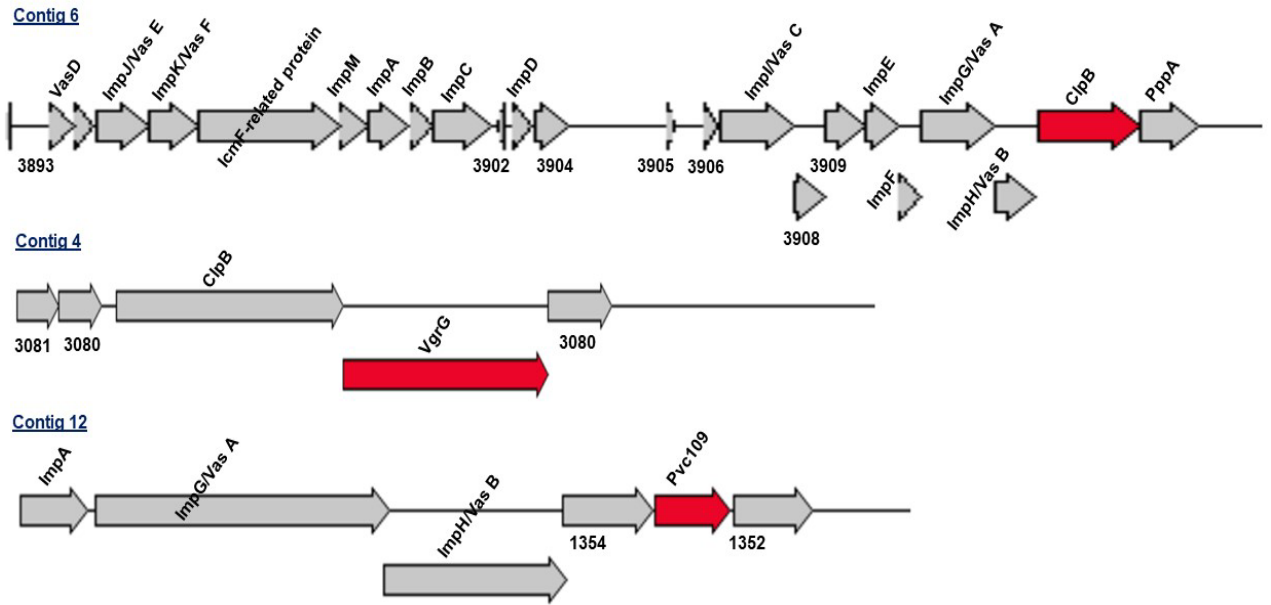
Figure 8. Genetic organization of 18 annotated T6SS gene clusters in P. stewartii subsp. stewartii Contig 6 ( VasD , ImpJ/Vas E , ImpK/Vas F , IcmF-related protein , ImpM , ImpA , ImpB , ImpC , ImpD , ImpI/Vas SQT1; Contig 6 ( VasD, ImpJ/Vas E, ImpK/Vas F, IcmF-related protein, ImpM, ImpA, ImpB, ImpC, ImpD, ImpI/Vas C, ImpE, ImpF, ImpG/Vas A, ImpH/Vas B, ClpB ); contig 4 ( ClpB, VgrG ); contig 12 ( ImpA, C , ImpE , ImpF , ImpG/Vas A , ImpH/Vas B , ClpB ); contig 4 ( ClpB , VgrG ); contig 12 ( ImpA , ImpG/Vas A ImpG/Vas A, ImpH/Vas B, Pvc109 ). PppA, ImpA, ImpG/Vas A , and ImpH/Vas B are found on contig 6 and contig 12, while ClpB is found on contig 6 and 4.